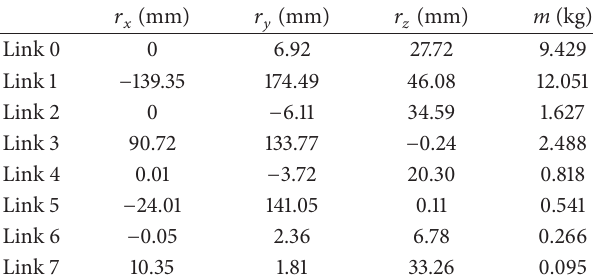
Table 5: Center of mass of the